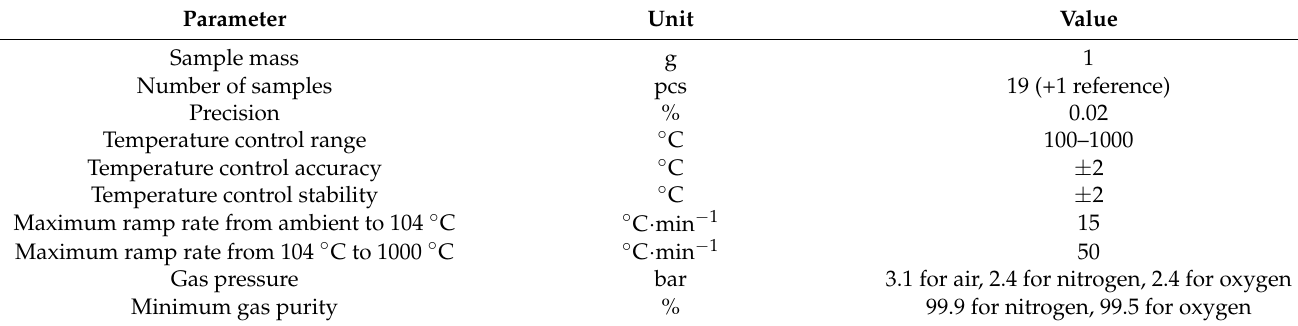
Table 2. Technical specification of TGA 701 analyzer.